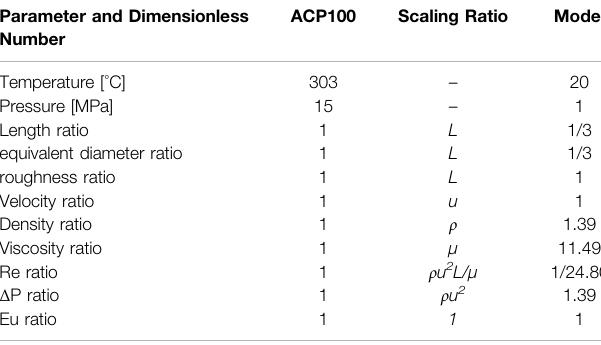
TABLE 1 | Scaling ratio of the mock-up reactor.